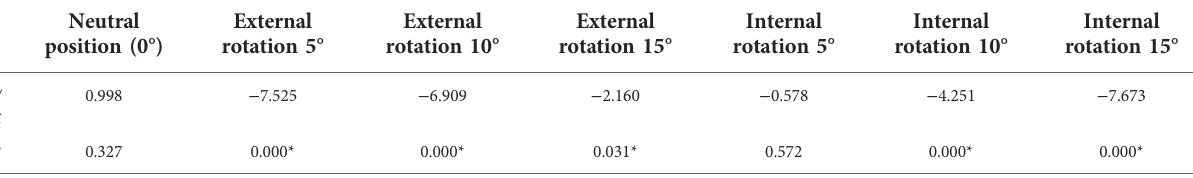
TABLE 4 Comparison of contact stresses between medial and lateral femoral – tibial side under 400